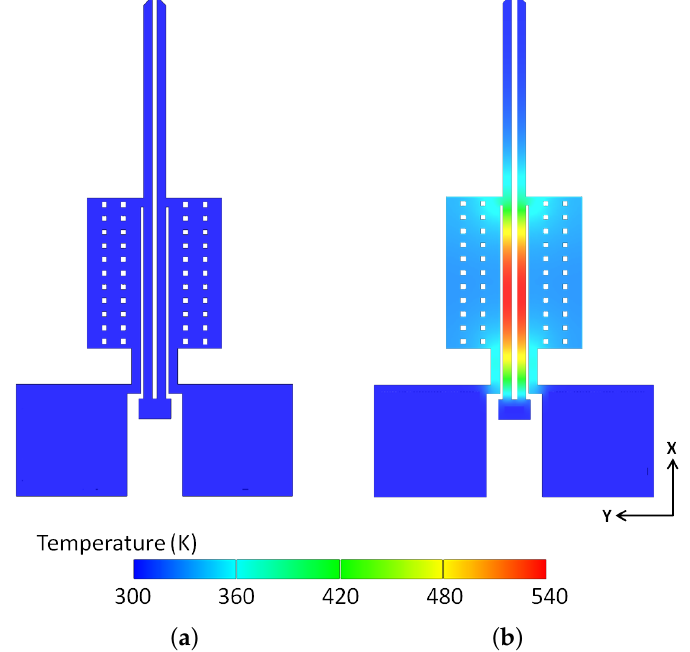
Figure 11. Simulated steady-state temperature profile of the polysilicon electrothermal microgripper: at no applied potential ( a ), and when each arm is subjected to an applied potential of 3 V ( b ). The maximum temperature at the applied potential of 3 V is 540 K and is located near the middle of the hot